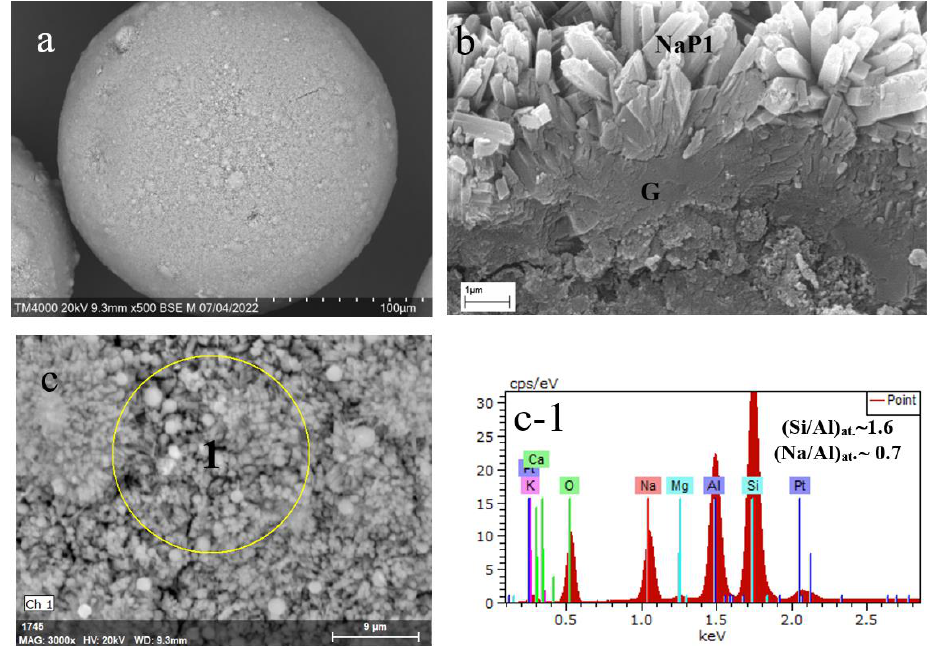
Figure 4. SEM images of product particles resulted from hydrothermal crystallization of cenosphere glass at 393 K ( a ), cross-section of the zeolitized shell ( b ); EDX spectra (c-1) for the local part of the zeolitized layer ( c ).